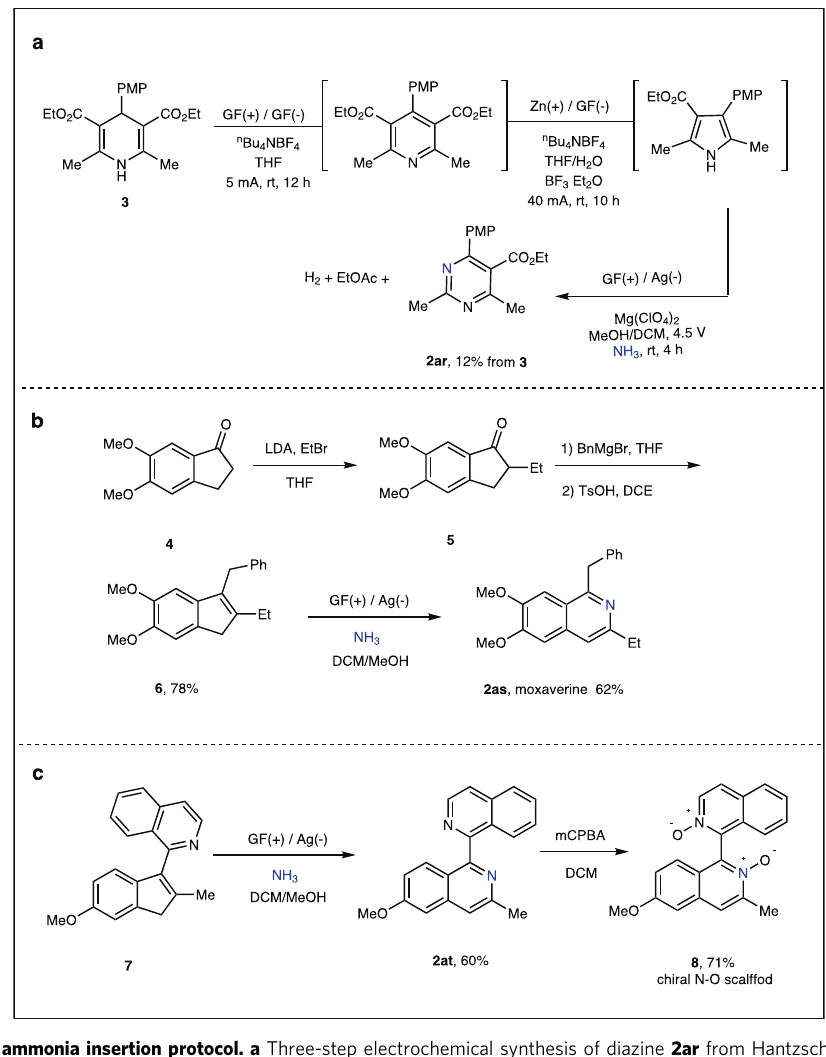
Fig. 3 The application of ammonia insertion protocol. a Three-step electrochemical synthesis of diazine 2ar from Hantzsch ester 3 . b Synthesis of choroidal blood regulator moxaverine 2as. c Synthesis of 6-methoxy-3-methyl-[1,1 ’ -biisoquinoline] 2,2 ’ -dioxide. GF, graphite felt; mCPBA; LDA, lithium diisopropylamide; 3-chloroperoxybenzoic acid, PMP,